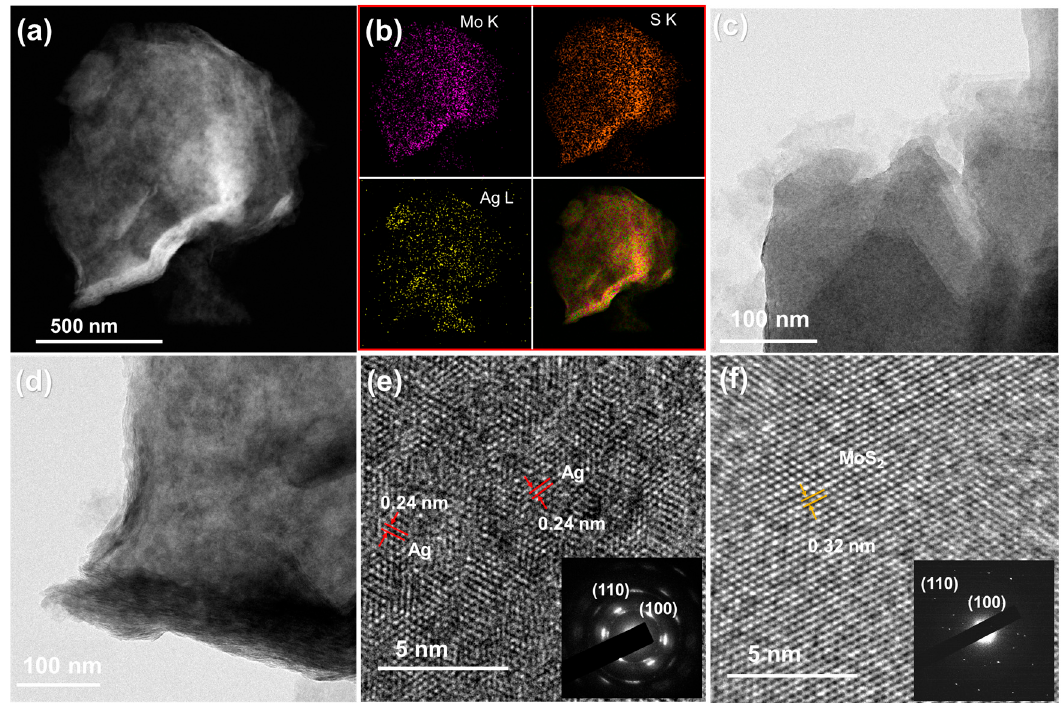
Figure 3. ( a , b ) Transmission electron microscopy (TEM) image and element mapping images of Ag3@MoS 2 materials; ( c , f ) TEM, high-resolution TEM (HRTEM) with inset selected area electron diffraction (SAED) pattern of MoS 2 NS; ( d , e ) TEM, HRTEM with inset SAED pattern of Ag3@MoS 2 materials.